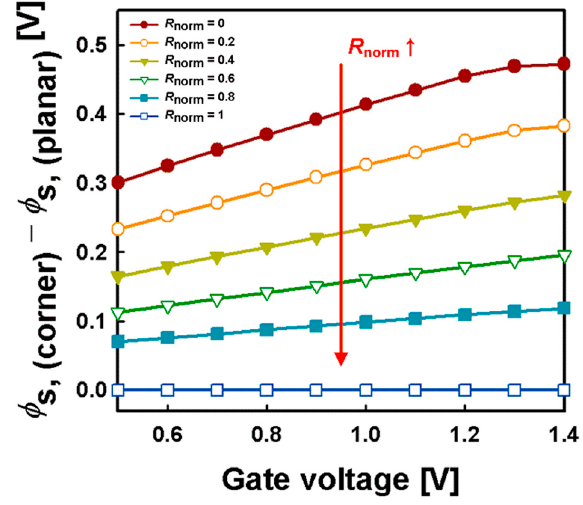
Figure 10. Surface potential difference between the corner and side with the variation in R norm .